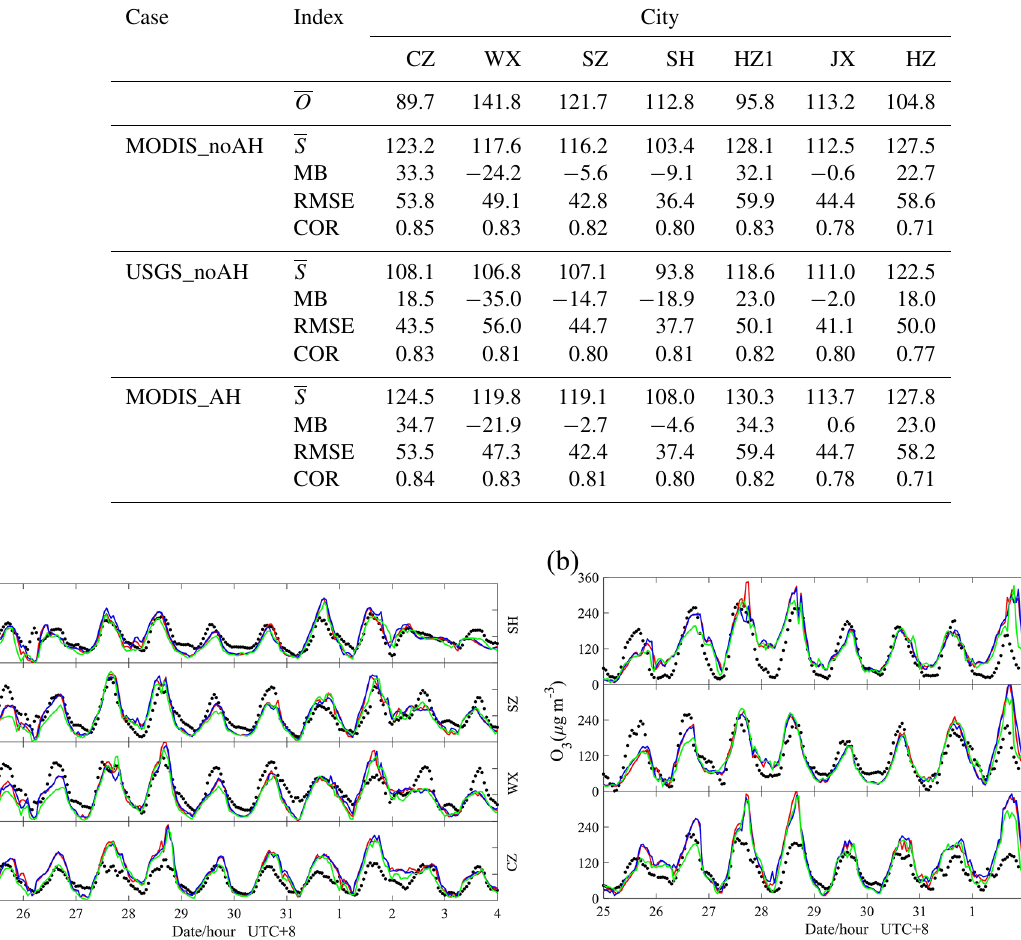
Figure 6. Same as Fig. 5 but for O 3